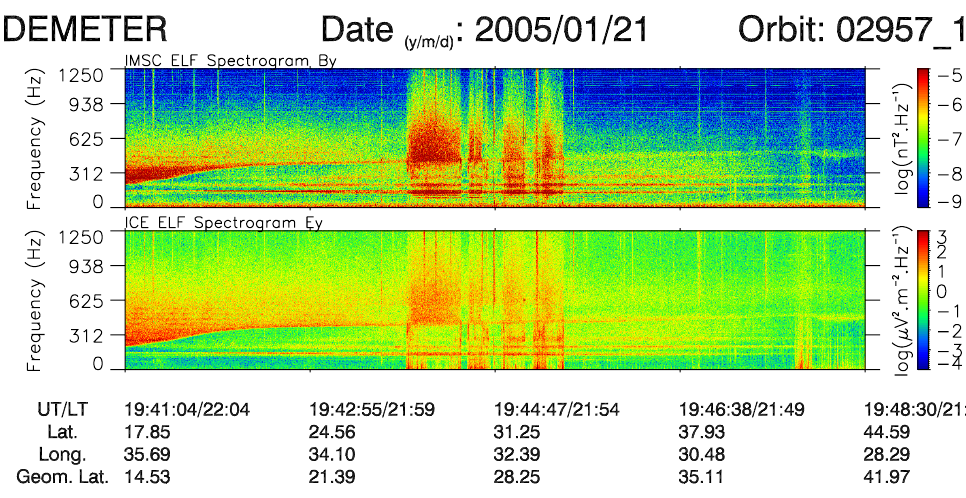
Fig. 5. Same as Fig. 1 but for the event recorded on 21 January 2005 (event